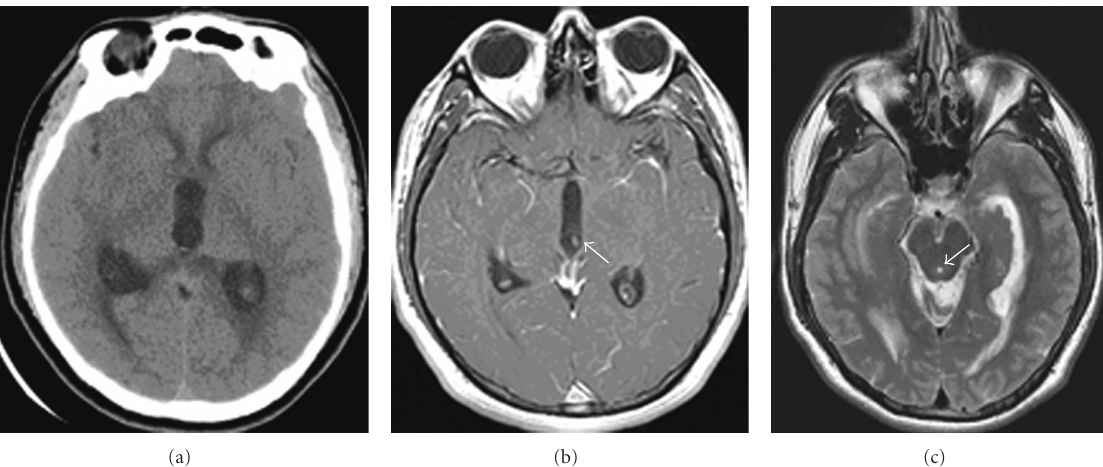
Figure 1: (a) CT head without contrast, (b) MRI T1 with contrast showing the cyst in the posterior third ventricle (arrow), and (c) MRI T2 showing altered flow through the Sylvian aqueduct (arrow).